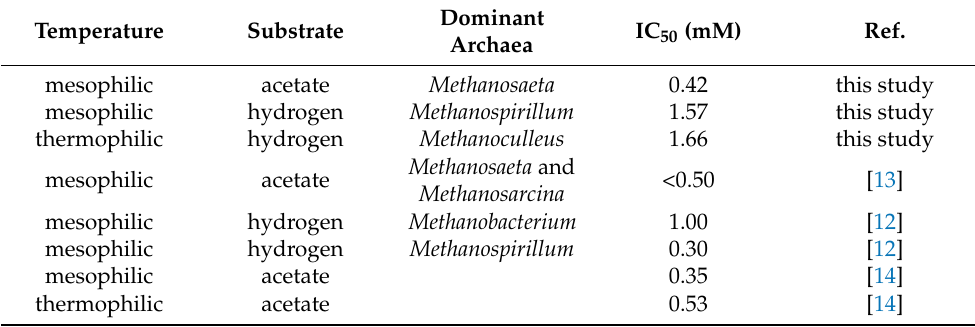
Table 3. Oleate IC 50 under different experimental conditions.